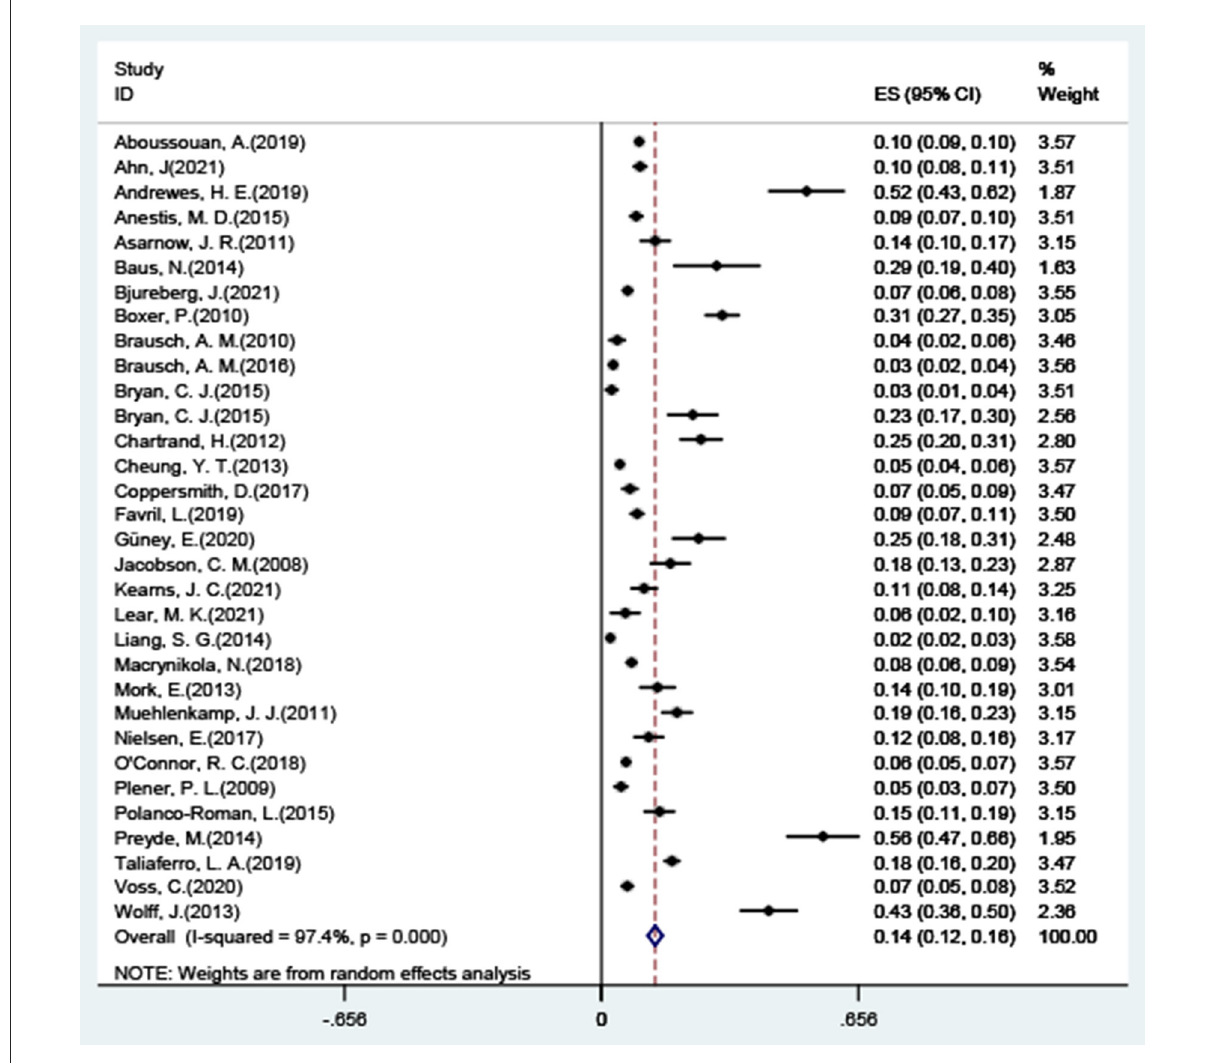
FIGURE3 Co-occurrence of NSSI + SA (excluding